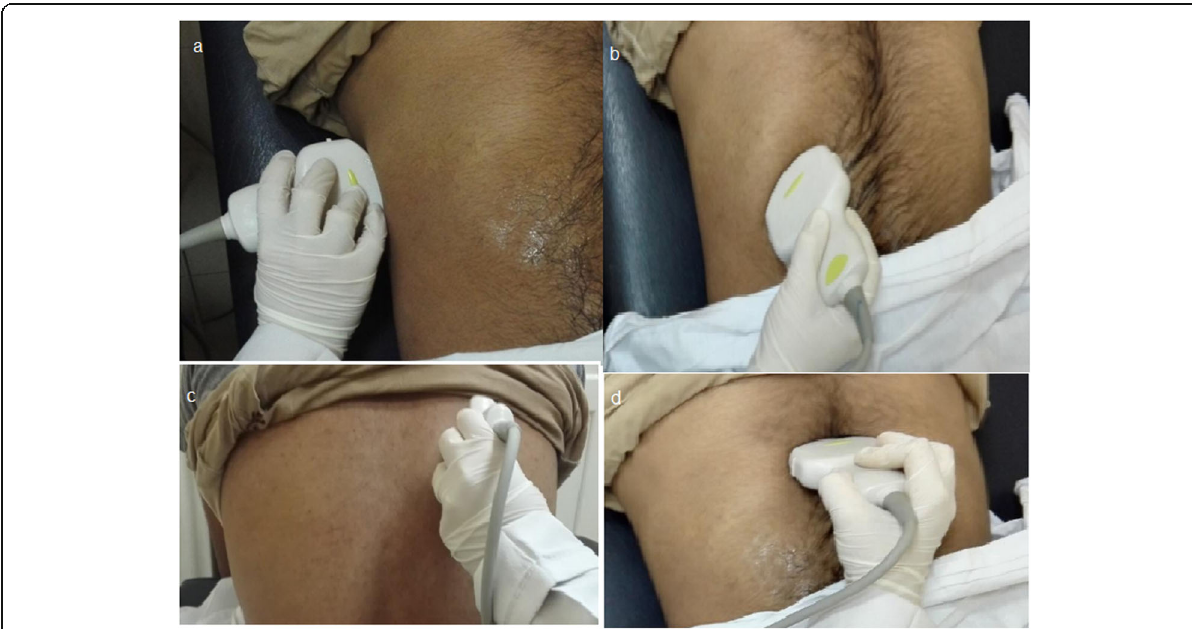
Fig. 1 a – d Photographic pictures demonstrating different probe and patients ’ positions for diaphragmatic ultrasound evaluation. a Probe positioning into the anterior axillary line to obtain the intercostal view at the zone of apposition. b Curvilinear probe was placed to obtain the anterior subcostal view. c Patient was sitting when the posterior subcostal view was obtained. d Subxiphoid view was obtained for qualitative assessment of both